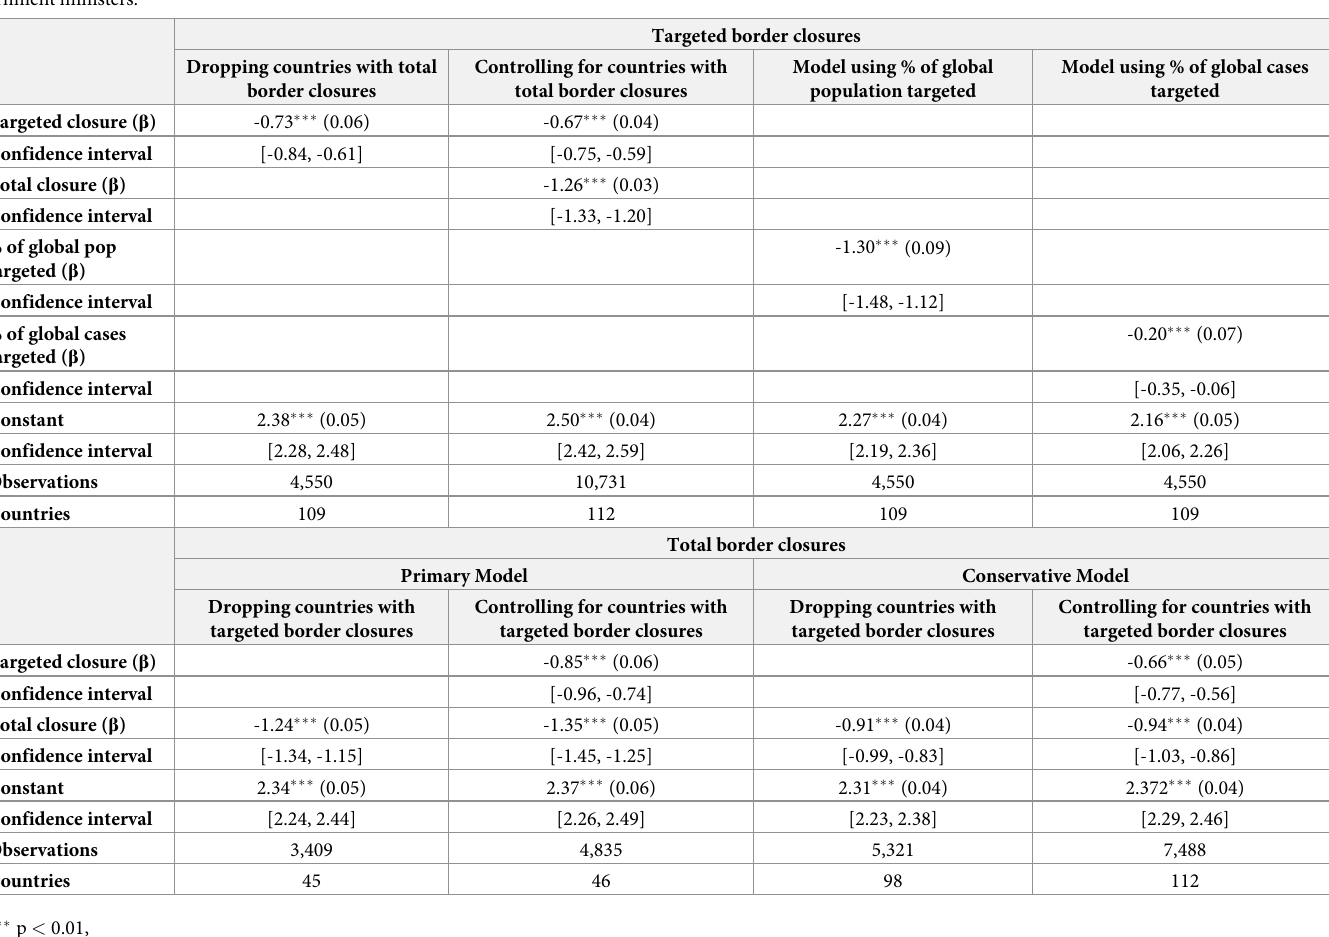
Table 2. Coarsened exact matching results. Maximum likelihood random-effects estimation for targeted and total border closures. Country-days are matched on coars- ened GHSI score, logged GDP, gender parity score, emigrants per capita, democracy index, logged airline passengers, health expenditures, and proportion of female gov- ernment